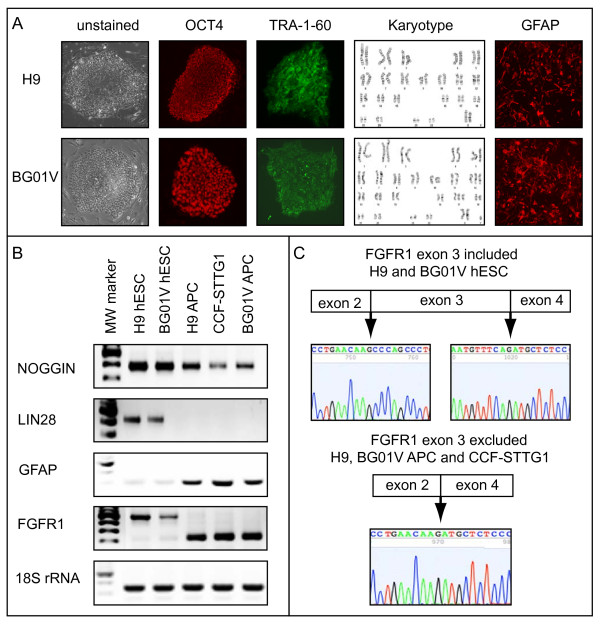
Diploid and trisomic astrocytic progenitors derived by directed in vitro differentiation of hESCs exhibit transcript and alternative splicing patterns characteristic of astrocytic cells. A. Diploid H9 and trisomic BG01V hESCs colonies (unstained, left panels), express stem cell markers OCT-4 (red) and TRA-1-60 (green). Karyotypes of diploid H9 (46; XX) and trisomic BG01V (49; XXY, +12, +17) hESCs. Diploid and trisomic APCs express astrocytic marker, GFAP (red). B. Semiquantitative RT-PCR analysis demonstrating that stem cell transcripts Noggin (top panel) and Lin28 (second panel) are over expressed in both diploid H9 and trisomic BG01V hESC lines relative to all astrocytic-like cells including H9 APCs, BG01V APCs and CCF-STTG1 astrocytoma cells. GFAP transcripts are up regulated in astrocytic cells relative to hESCs (middle panel). Alternative splicing pattern of FGFR1 in diploid H9 hESCs is preserved in trisomic BG01V hESCs relative to all astrocytic cells. 18S RNA was used as control in all RT-PCR experiments (bottom panel). MW marker is included in the far left lane in each gel. C. DNA sequence analysis demonstrating that the FGFR1 transcript expressed in diploid H9 and trisomic BG01V hESCs includes exon 3, while astrocytic cells express a FGFR1 splice variant in which exon 3 has been excluded (from FGFR1 RT-PCR analysis in Figure 1B).